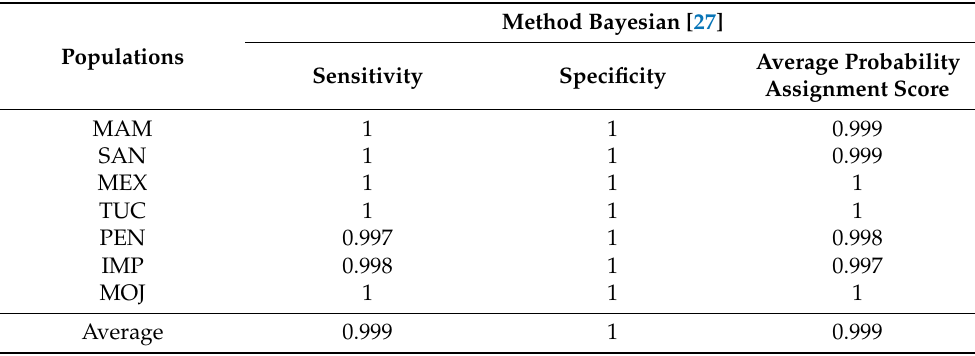
Table 4. Performance of identification of the simulated genotypes of Arapaima gigas from three wild and four farmed populations. Method Bayesian [27] Populations Sensitivity